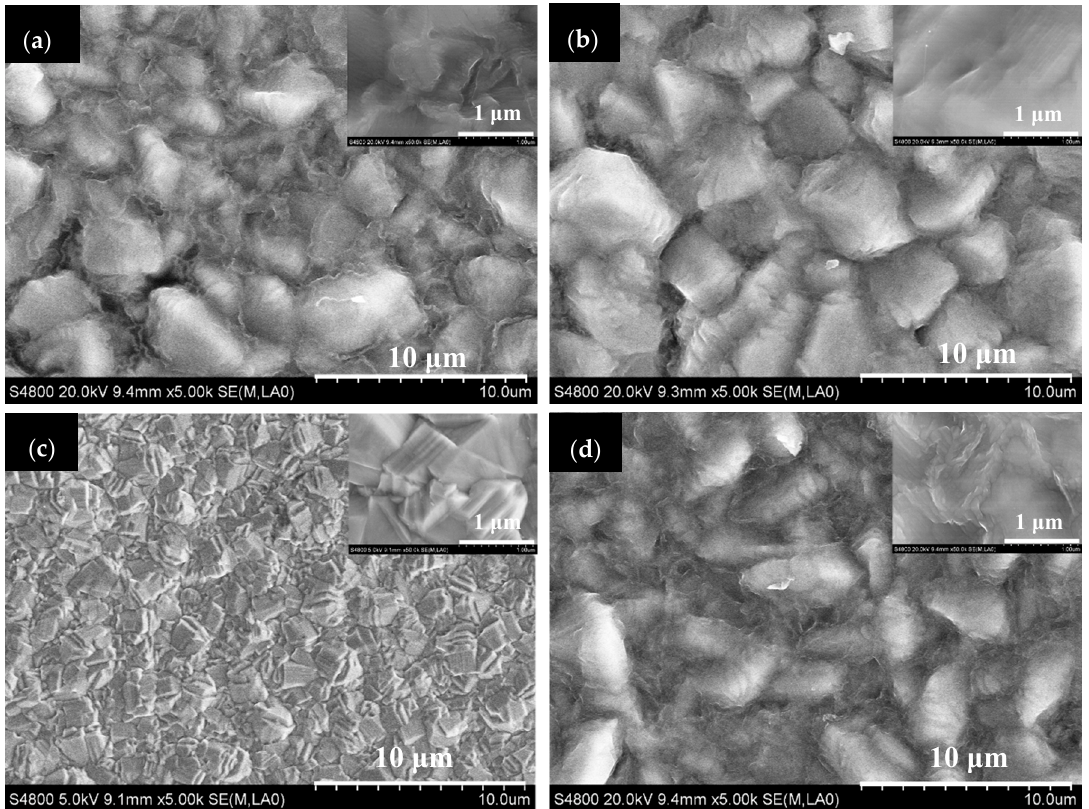
Figure 3. SEM images of the TiO 2 coating at 800 °C for 1.5 h at different times of the total flow rate: ( a ) 0.4, ( b ) 0.6, ( c ) 0.8, and ( d ) 1.4 times.